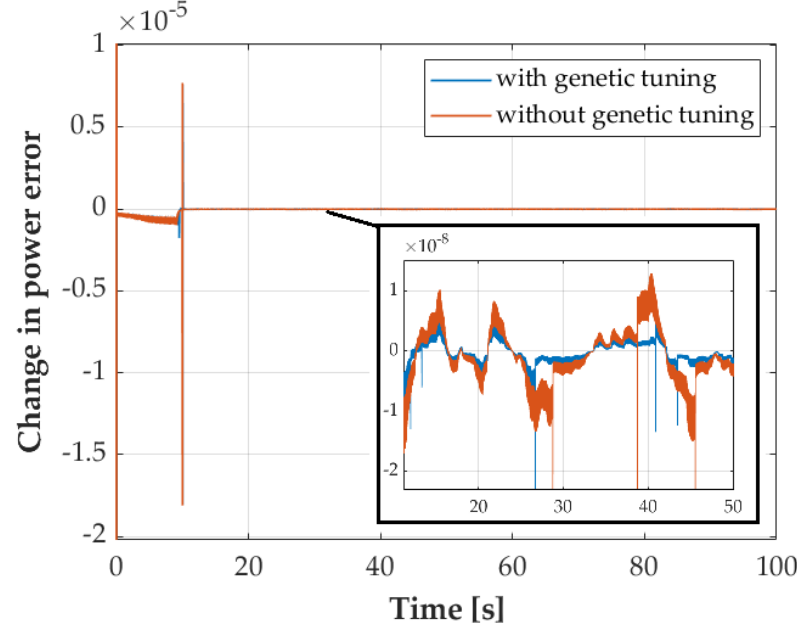
Figure 11. Change in power error with (blue line) and without (red line) using genetic algorithm.